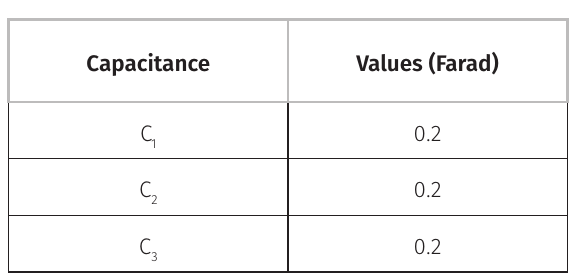
Table II. Capacitance of Skin.